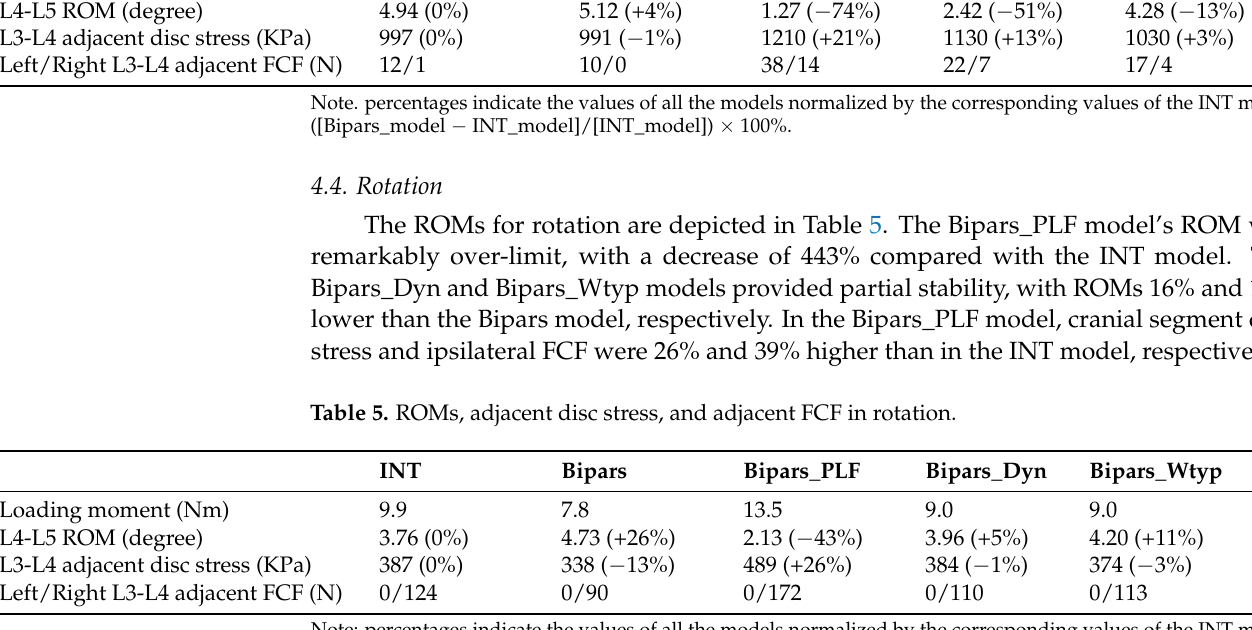
Figure 7. Adjacent disc stress (L3–L4) in extension. Note: Red arrows indicate points of high stress.